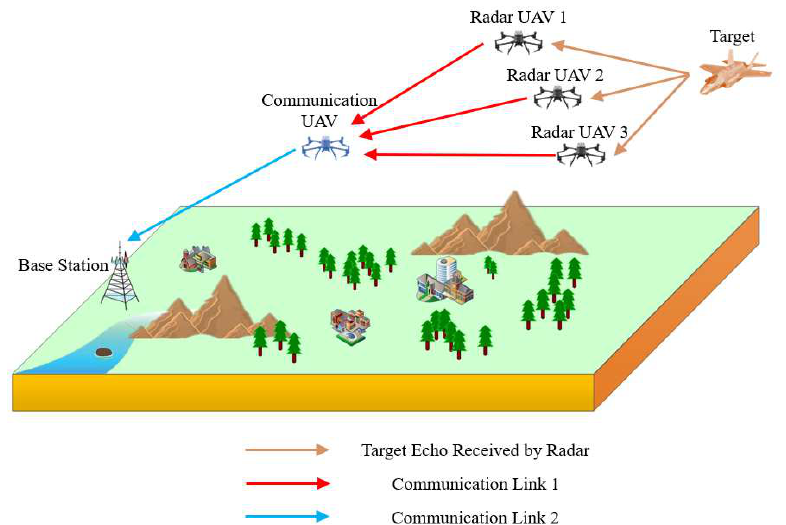
Figure 1. Schematic diagram of ADCR communication system.